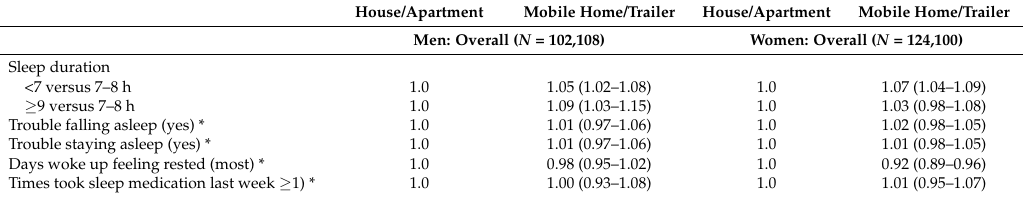
Table 2. Fully Adjusted Prevalence Ratios for Sleep Duration and Sleep Difficulties for Mobile Home/Trailer Residents Compared to People in Houses/Apartments, among U.S. Men and Women (Black and White): National Health Interview Survey, 2004–2015 ( N = 226,208).